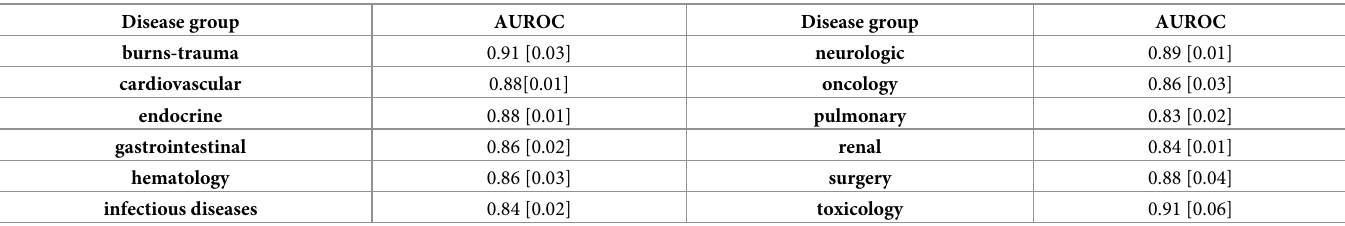
Table 6. Cross-validation (mean AUROC [standard deviation AUROC]) results of E-CatBoost model using 10-fold cross-validation. Disease group AUROC Disease